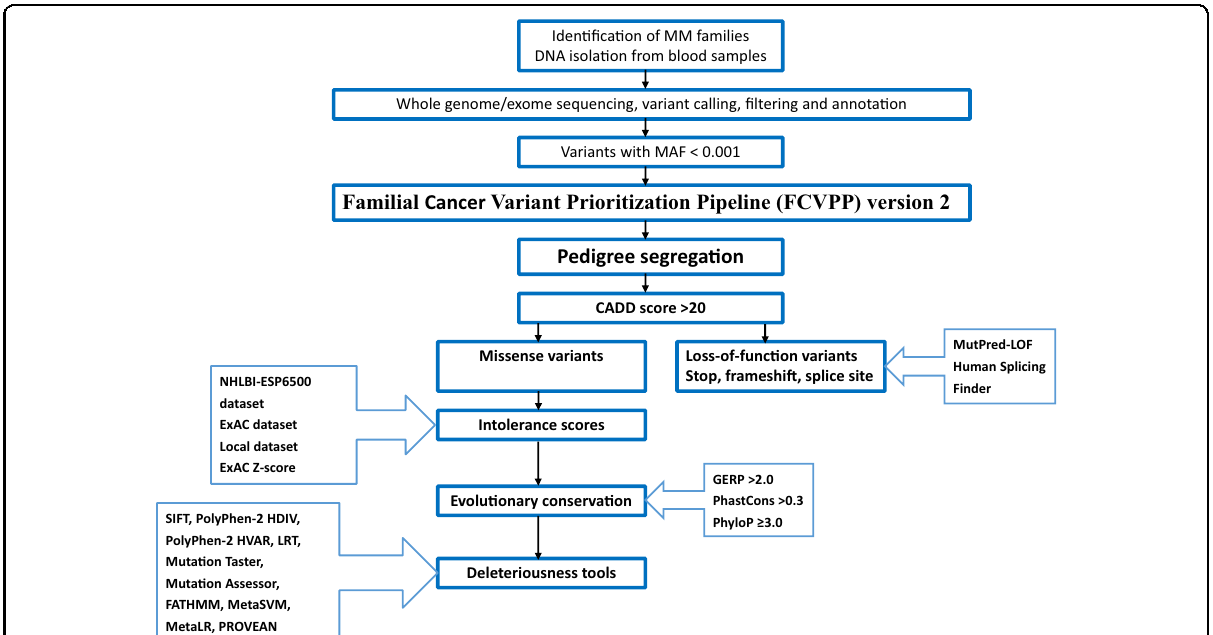
Fig. 1 Pipeline for identi fi cation of missense and loss-of-function variants in the multiple myeloma families. After identi fi cation of the families, DNA isolation from the blood samples and whole genome or exome sequencing, variant calling, fi ltering, and annotation, we used our in- house developed Familial Cancer Variant Prioritization Pipeline v.2 to identify the most likely cancer predisposition variants for multiple myeloma. All variants with minor allele frequency (MAF) < 0.001 that segregated with the disease in the families were fi ltered by CADD score >20, which indicates the top 1% of potentially deleterious variants in the human genome. For missense variants, the corresponding genes were screened for their intolerance against functional variants using the NHLBI-ESP6500, ExAc, and local data sets as well the ExAC Z-score. The location of the variants was checked for evolutionary conservation using GERP (>2.0), PhastCons (>0.3), and PhyloP ( ≥ 3.0). Ten tools were used to predict the deleteriousness of the variants: Sorting Intolerant from Tolerant (SIFT), Polymorphism Phenotyping version-2 (PolyPhen-2) HDIV (HumDiv), PolyPhen-v2 HVAR (HumVar), Log ratio test (LRT), MutationTaster, Mutation Assessor, Functional Analysis Through Hidden Markov Models (FATHMM), MetaSVM, MetaLR, and Protein Variation Effect Analyzer (PROVEAN). For loss-of-function variants (frameshift and stopgain), pathogenic and neutral variants were predicted using MutPred-LOF with a threshold score of 0.50 at a 5% false-positive rate. Human Splicing Finder was used to evaluate the effect of splice site variants, with a yes/no